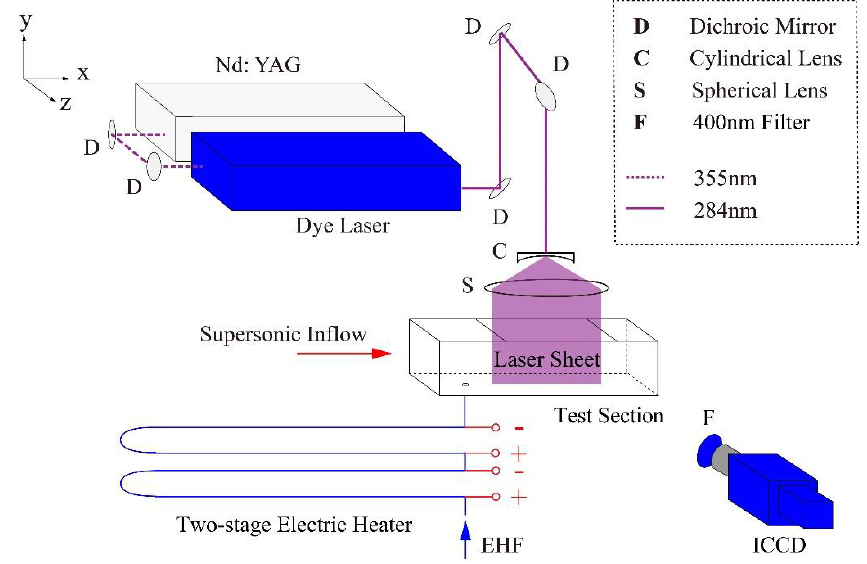
Figure 1. Schematic of experimental setup.